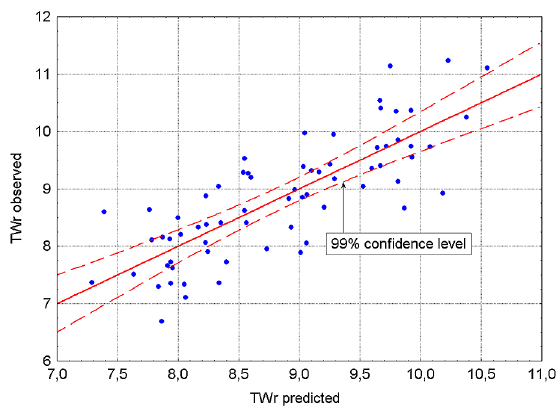
Fig. 8. The predicted (from Eq. (2)) values of annual air temperature in Wrocław (TWr) in relation to the observed values. The dotted line indicates 99% confidence interval